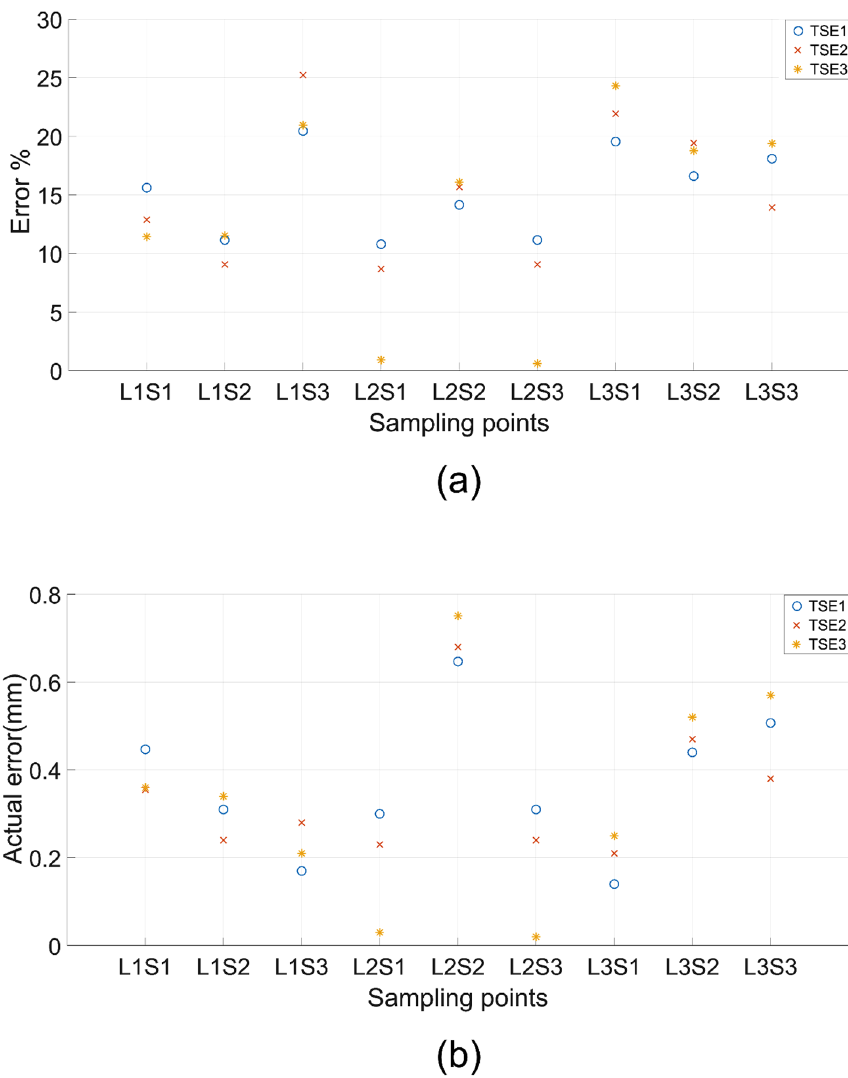
Figure 21. The percentage error ( a ) and the actual error ( b ) between the target set TSE1-TSE3 and the three- point bending test result of the printed